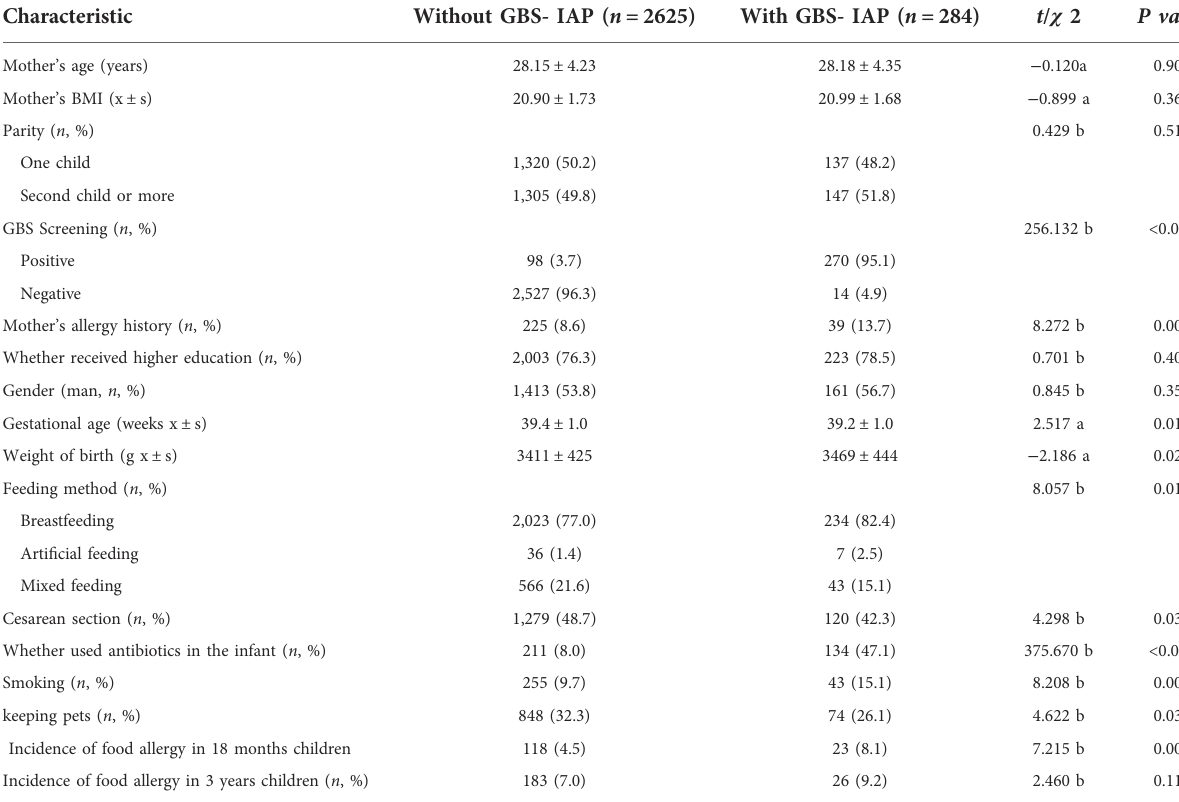
TABLE 1 Demographic and other characteristics of study